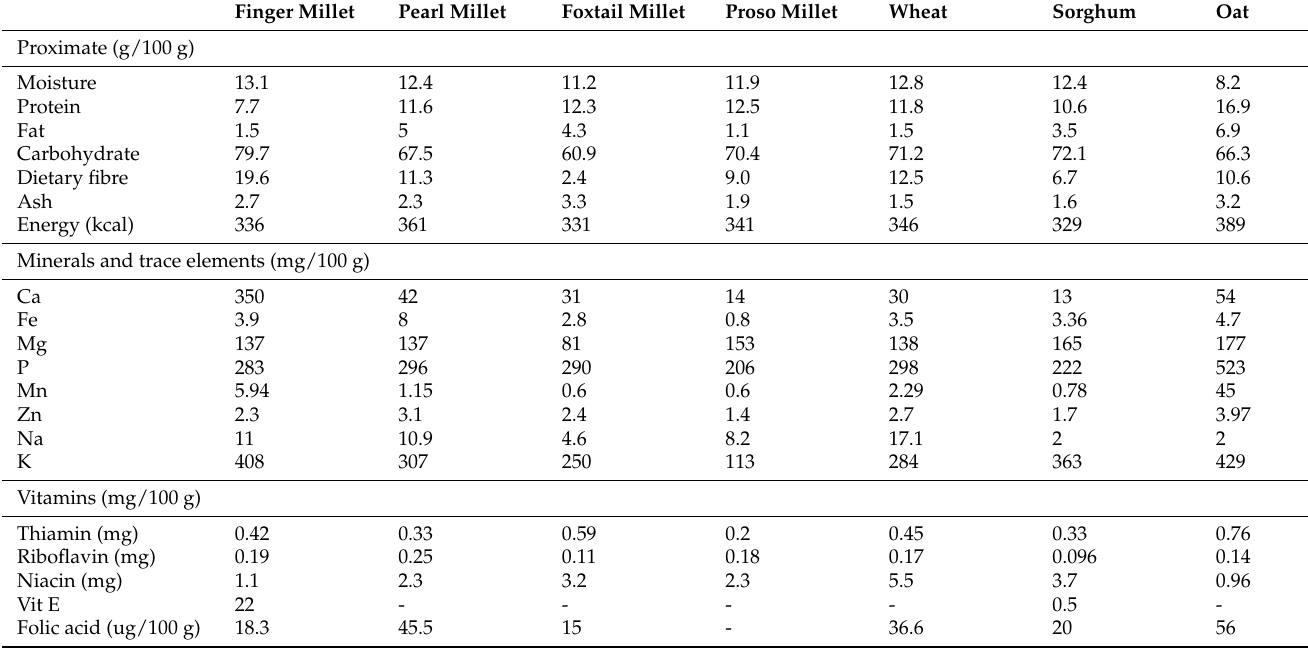
Table 1. Nutritional composition of finger millet and other cereal